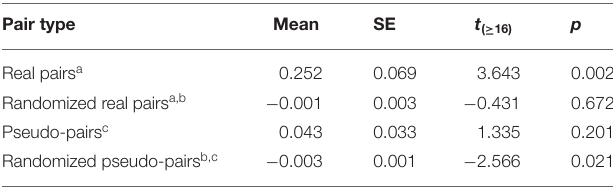
TABLE 3 | Mean and standard error of provisioning CTH rate in real pairs, randomized real pairs, pseudo-pairs, and randomized pseudo-pairs of great tits.